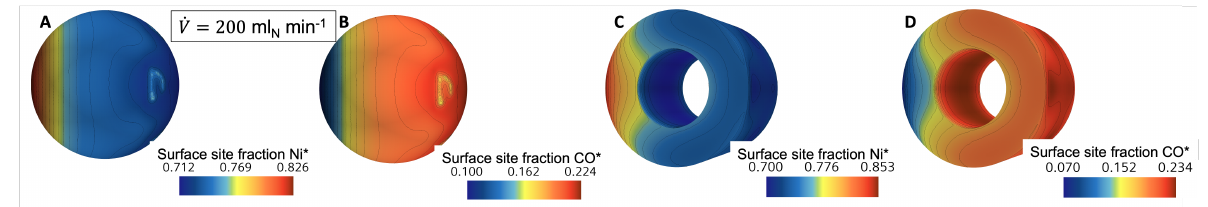
Figure 5. Adsorbed species ( A , C ) Ni ∗ and ( B , D ) CO ∗ on sphere and ring inside Temkin single chamber. ˙ V = 200 ml N min − 1